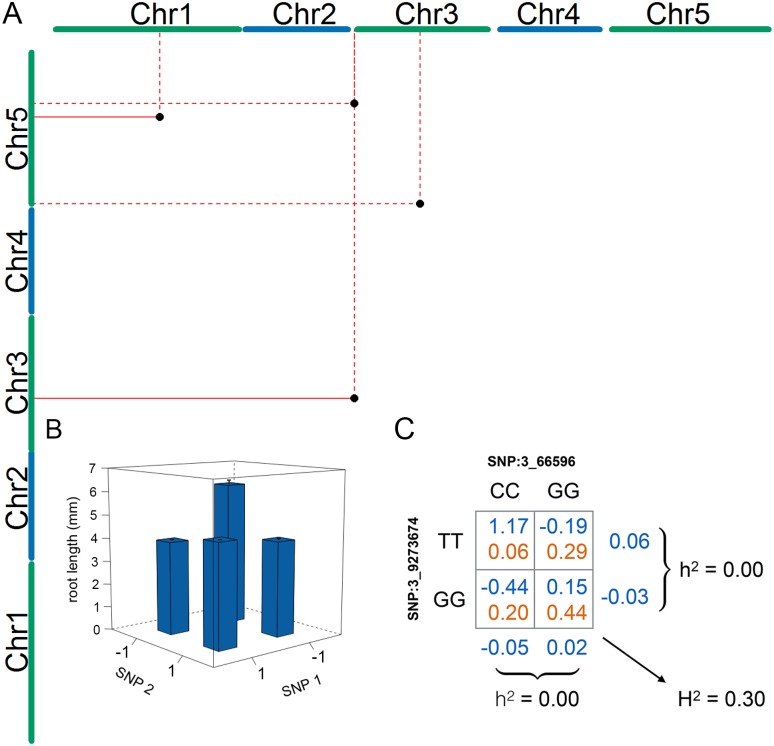
Four statistical epistatic interactions associated with mean root length.(A) The x- and y-axes represent the five A. thaliana chromosomes. The positions of the seven SNPs that are part of the four significant interacting pairs (Table 2) are indicated by a black dot. Solid lines indicate support for an interaction by more than one linked SNP and dotted lines indicate support by a single SNP. (B) Genotype-phenotype (G-P) map of the root means for the four genotype combinations constituting the interaction between the SNPs on chromosome 1 (17,257,526 bp) and chromosome 5 (15,862,026 bp). The major allele is indicated by -1, and the minor allele is indicated by 1. This G-P-map is a representative example for the other pairs in which the accessions with a minor and major allele have lower phenotypic values than those with either both major or both minor alleles (S2 Fig). (C) G-P map for the most significant epistatic pair illustrates how this type of epistasis cancels the additive genetic variance at the allele-frequencies observed for the two loci in the analyzed population of wild-collected A. thaliana accessions.